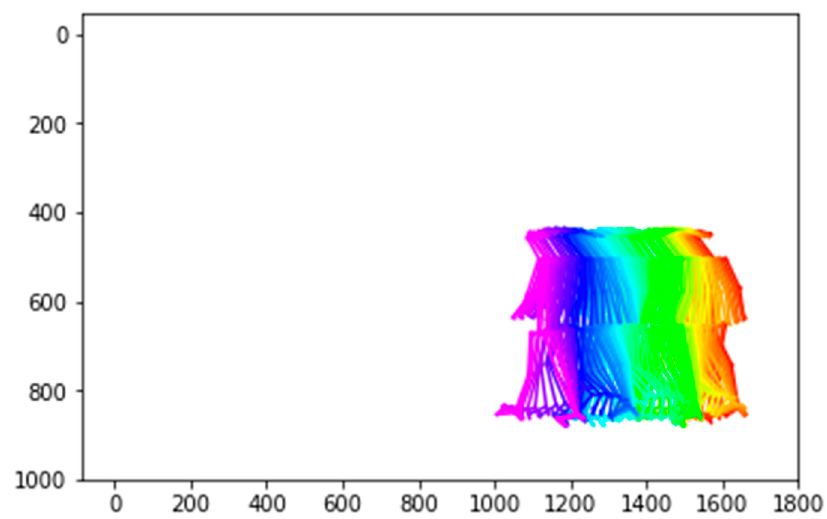
Figure 6. Schematic diagram of walking data. Algorithm 1. Data normalization